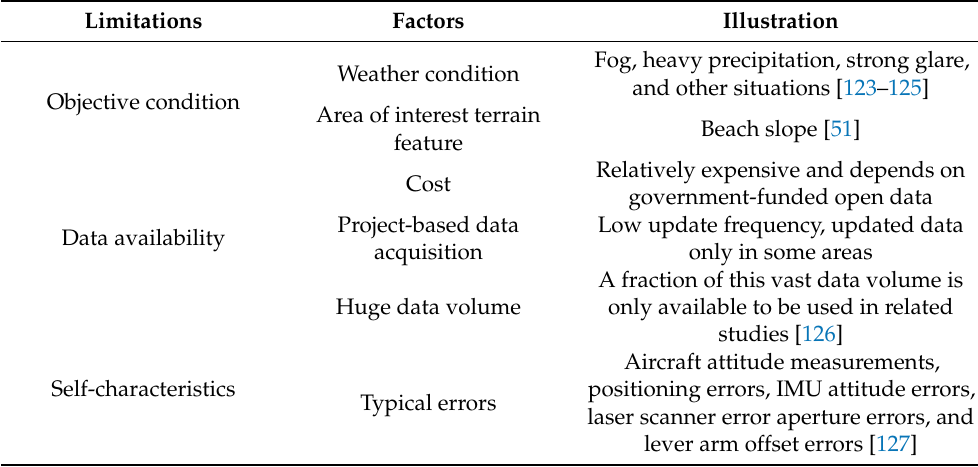
Table 6. Main Limitation of Shoreline Mapping by Using Airborne